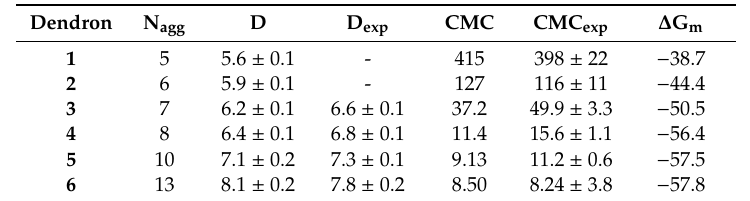
Figure 1. The computer simulation of the self-assembled micelles generated by the amphiphilic dendrons 4 ( a ), 3 ( b ), and 2 ( c ). In all panels, the hydrophilic PAMAM head is portrayed as purple and lilac beads, the hydrophobic tail is represented by light gray beads while the linker between the hydrophilic and the hydrophobic portion of the molecule is shown as green beads. Water and counterions are portrayed as a gray field for clarity. The right images in each panel show only the micellar cores. ( d , left ) Zoomed view of the micelles formed by dendron 4 . The micellar cores are highlighted by a light gray surface. ( d , right ) Computer simulation of the non-amphiphilic dendron 8 selected as negative control, showing the non-self-assembling characteristics of this system. Table 1. Micelle aggregation number (N agg ), surface charge density ( σ m , e /nm 2 ), diameter (D, nm), critical micelle concentration (CMC, μ M) and free energy of micellization ( Δ G m , kJ/mol) for dendrons 1 – 6 as predicted by computer simulations. The corresponding experimental values of the micelle diameter (D exp , nm) and critical micelle concentration (CMC exp , μ M) are also reported. Adapted from [7] with the permission of John Wiley and Sons.